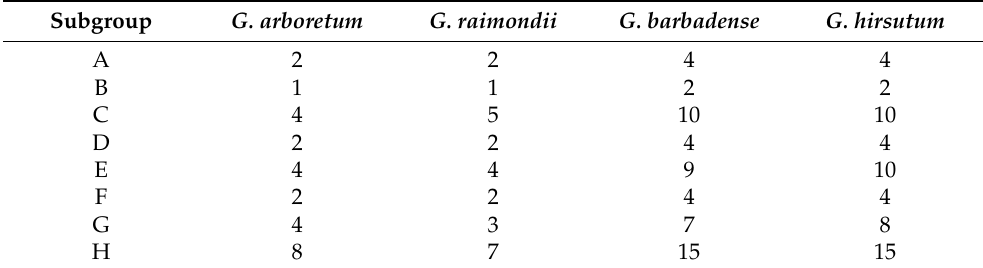
Table 3. Numbers of EXO70s in each subgroup of different cotton